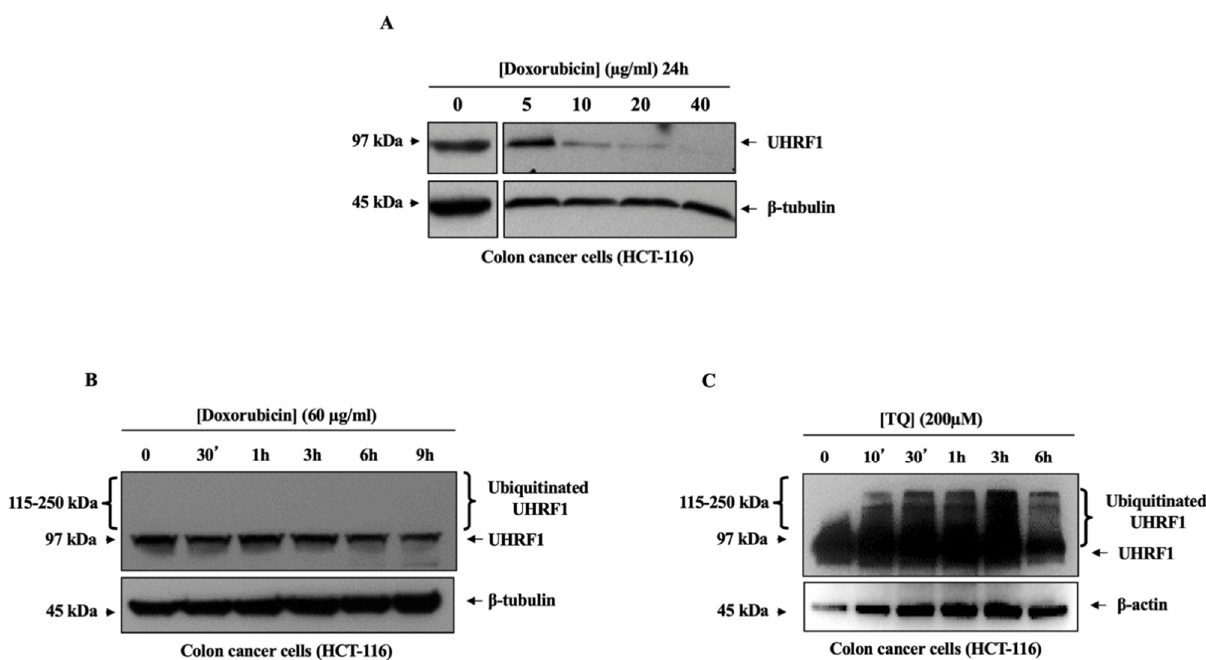
Figure 4. Dose- and time-dependent effects of doxorubicin or TQ on the protein expression of UHRF1 and ubiquitinated UHRF1 in colon cancer cells. ( A ) HCT-116 cells were exposed to increasing concentrations of doxorubicin for 24 h. ( B ) Cells were exposed to 60 µ g/mL doxorubicin for different times. ( C ) Cells were exposed to 200 µ M TQ for different times. Expression of UHRF1 was analyzed via Western blotting, as described in the Materials and Methods.